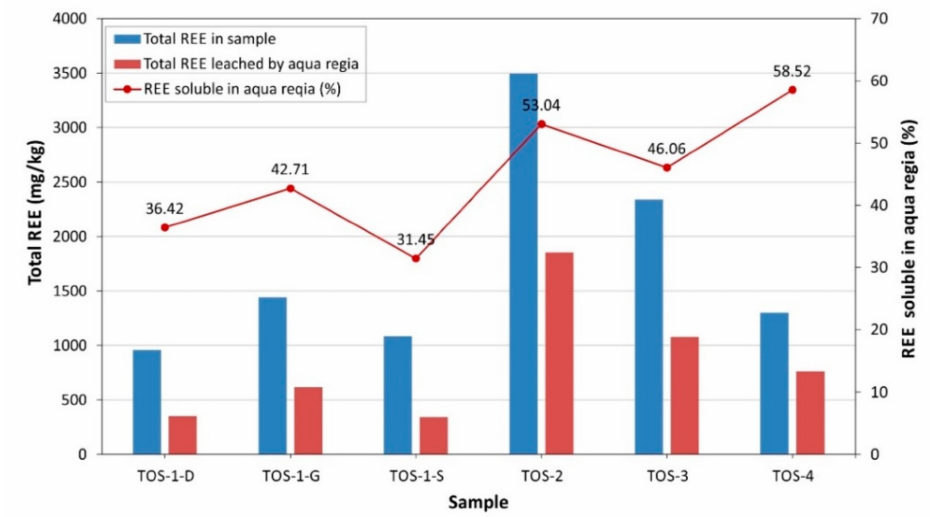
Figure 7. Total REE content leached out of the bauxite samples by a modified aqua regia digestion compared to total REE content in the